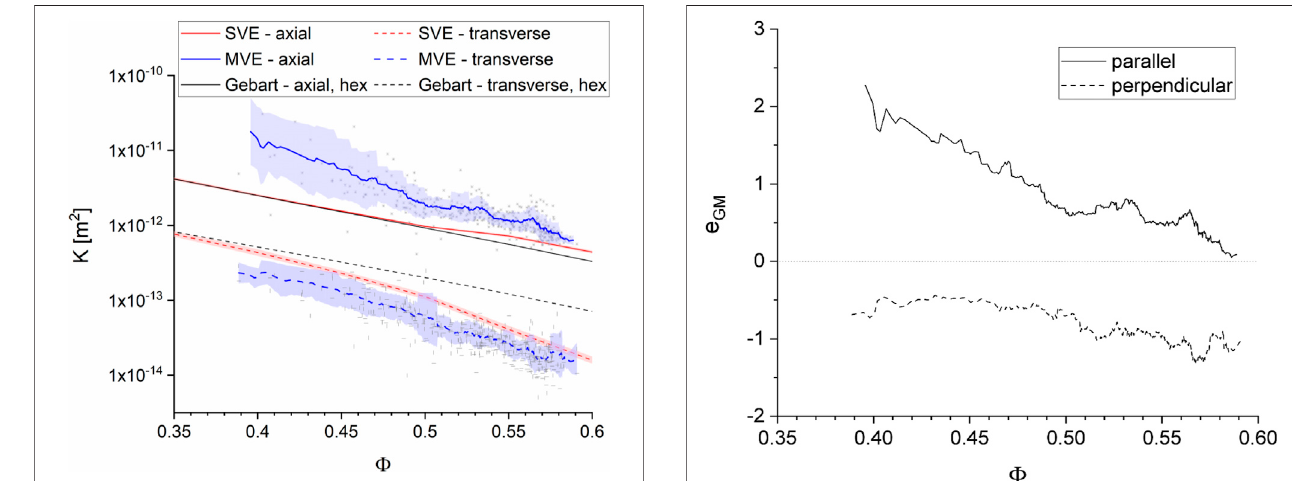
FIGURE 15 | Normalized difference between SVE and MVE